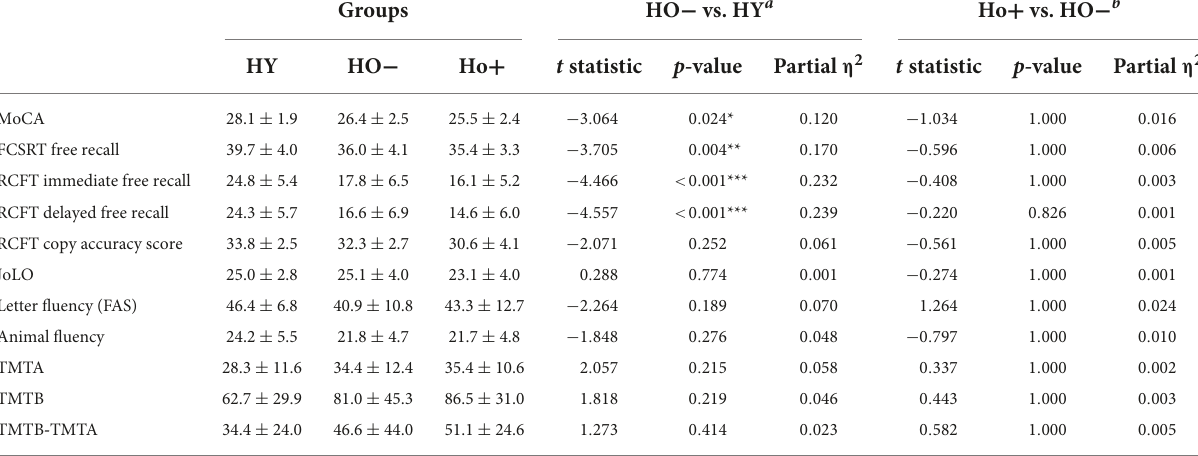
TABLE 2 Neuropsychological assessments.